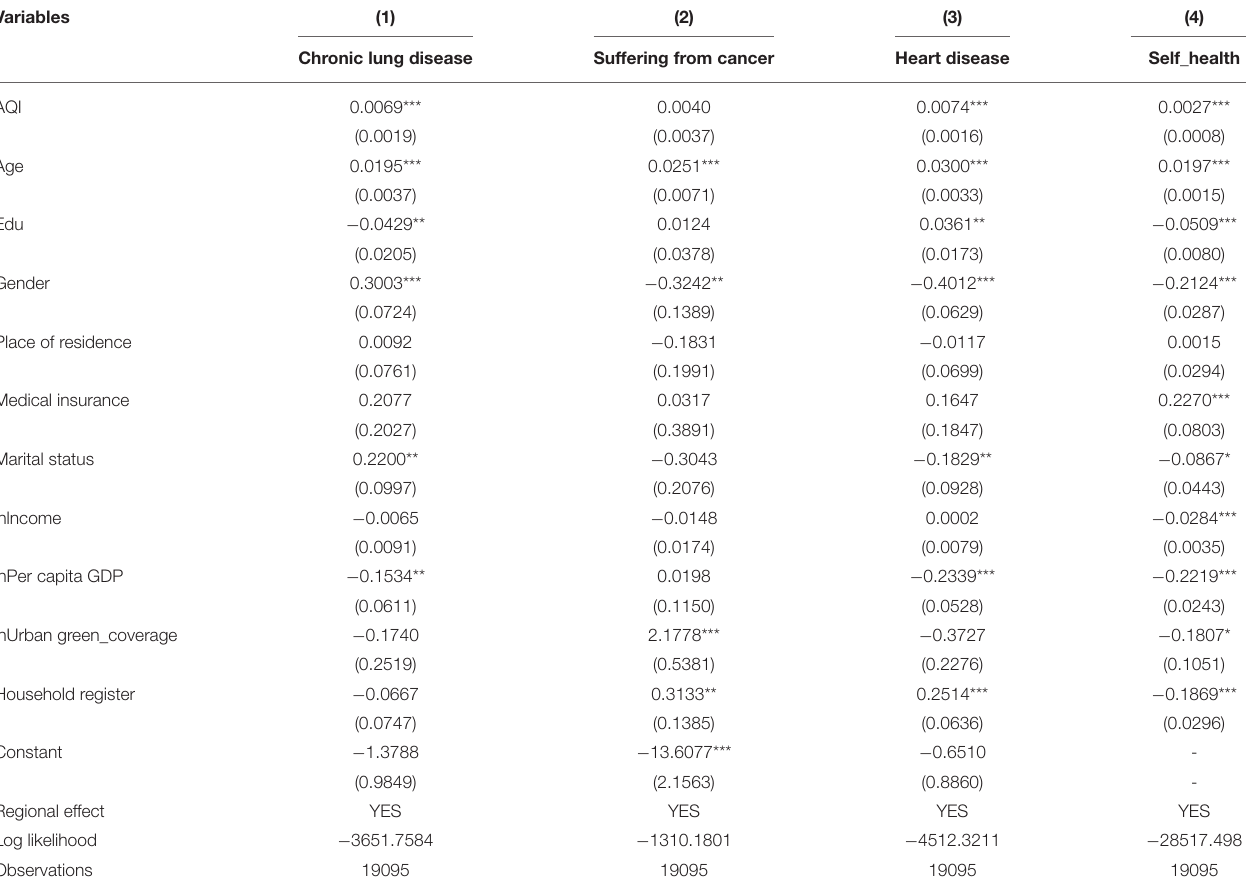
TABLE 2 | Air pollution and health